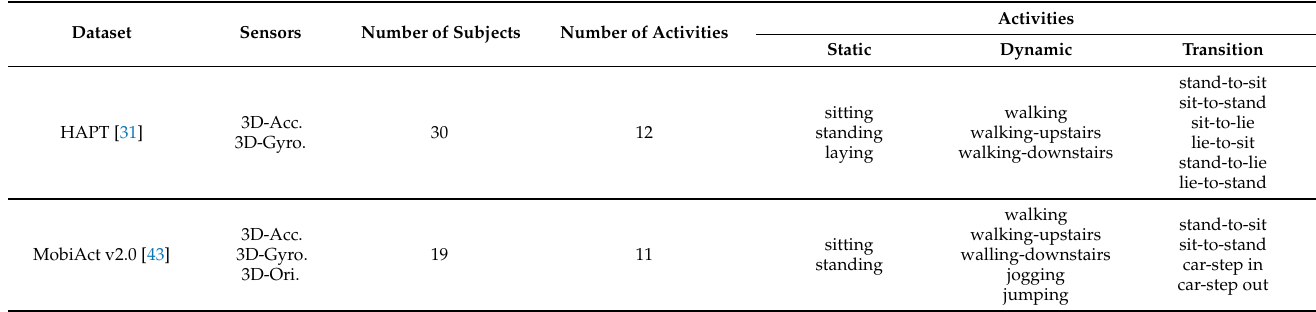
Table 2. Details of two benchmark HAR datasets used in this study.